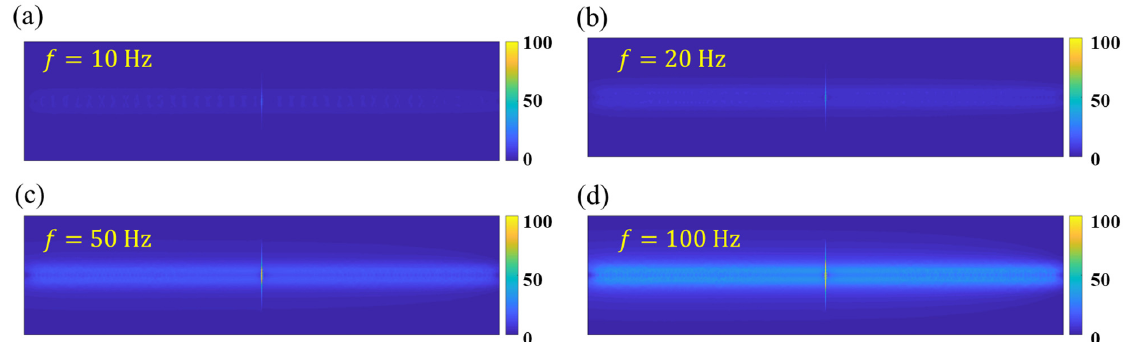
Figure 10. T G at different thermal image acquisition frequencies ( v = 10 mm/s, P = 1200 mW and Figure 10. 𝑇 (cid:3008) at different thermal image acquisition frequencies ( 𝑣 = 10 mm/s, 𝑃 = 1200 mW and acquisition time is 2 s): ( a ) 𝑓 = 10 Hz; ( b ) 𝑓 = 20 Hz; ( c ) 𝑓 = 50 Hz; ( d ) 𝑓 = 100 Hz. acquisition time is 2 s): ( a ) f = 10 Hz; ( b ) f = 20 Hz; ( c ) f = 50 Hz; ( d ) f = 100